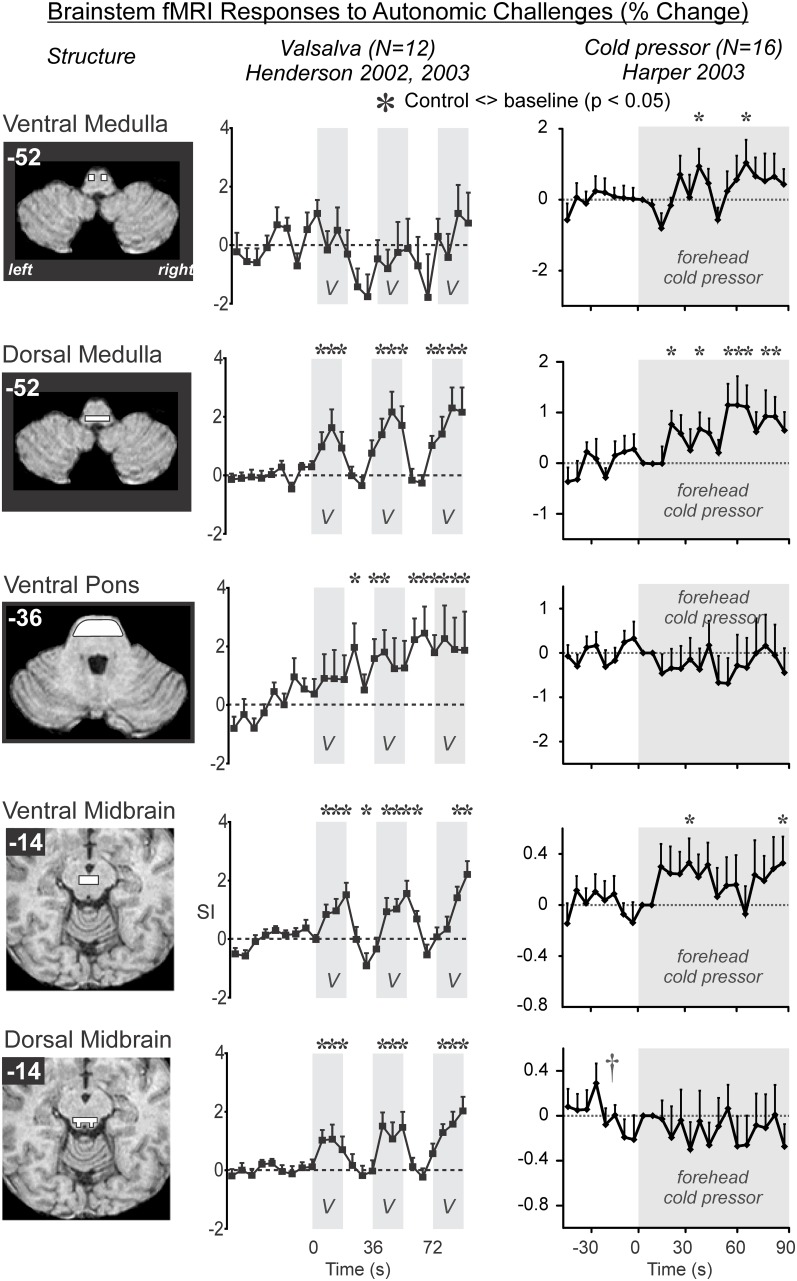
Brainstem involvement during autonomic challenges detected by fMRI. A “*” symbol indicates a timepoint of significant signal increase relative to baseline, by repeated measures ANOVA at P < 0.05 (Data from Henderson et al., 2002; Harper et al., 2003; Henderson et al., 2003).